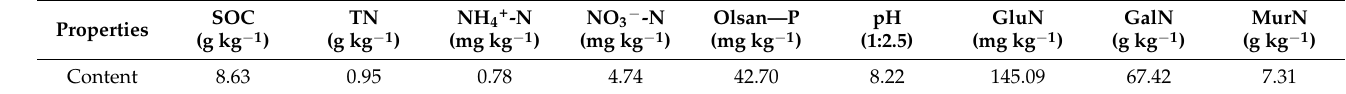
Table 1. Soil properties before the experiment in